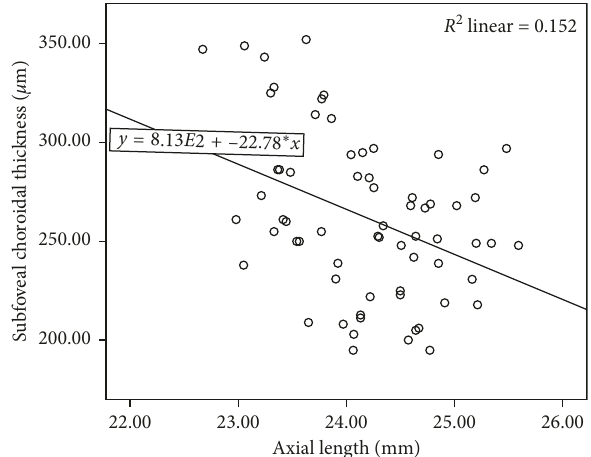
Figure 4: Association between subfoveal choroidal thickness and axial length in the mild myopia group.